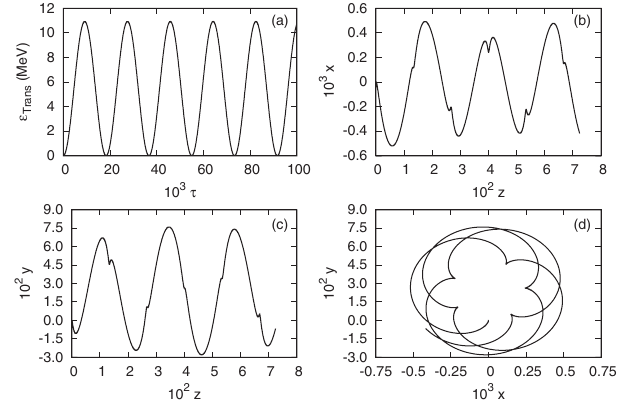
FIG. 5. Temporal evolution of the transverse kinetic energy (a) is plotted along with the trajectory in the x - z plane (b), y - z plane (c), and x - y plane (d) with the detuned phase modulation factor (cid:3) ¼ 0 : 5001 .